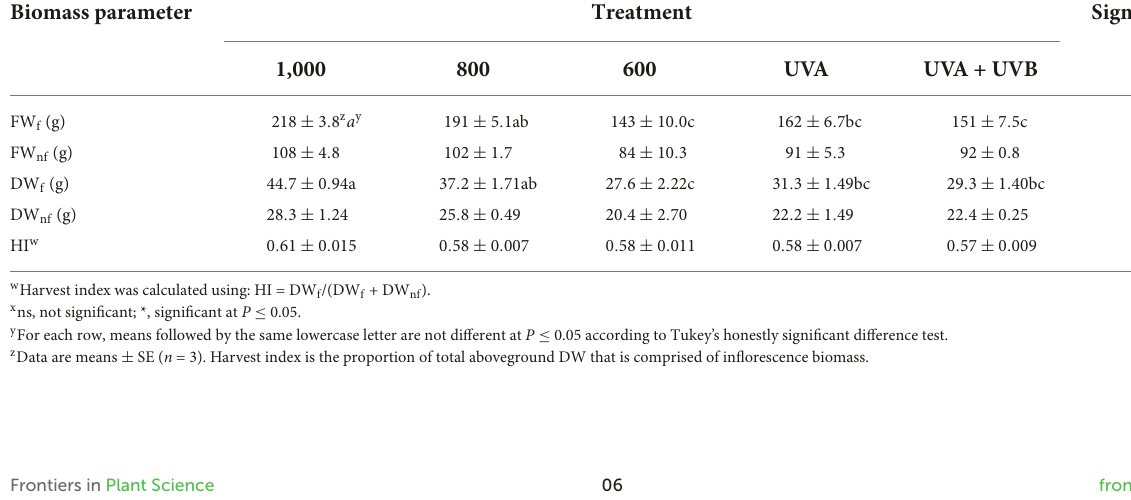
TABLE 2 Per-plant fresh weight of inflorescence (FW f ) and non-floral aboveground (FW nf ) tissues, dry weight of inflorescence (DW f ) and non-floral aboveground (DW nf ) tissues, and harvest index (HI) of Cannabis sativa ‘Meridian’ plants grown under light emitting diodes (LEDs) for 45 days under average canopy-level photosynthetic photon densities (PPFD) of either 600, 800, or 1,000 µ mol m − 2 s − 1 for 12 h day − 1 or PPFD of 600 µ mol m − 2 s − 1 plus ultraviolet (UV, 280–400 nm) of either 12 h day − 1 of 50 µ mol m − 2 s − 1 from LEDs with peak wavelength of 385 nm for 45 days (UVA)